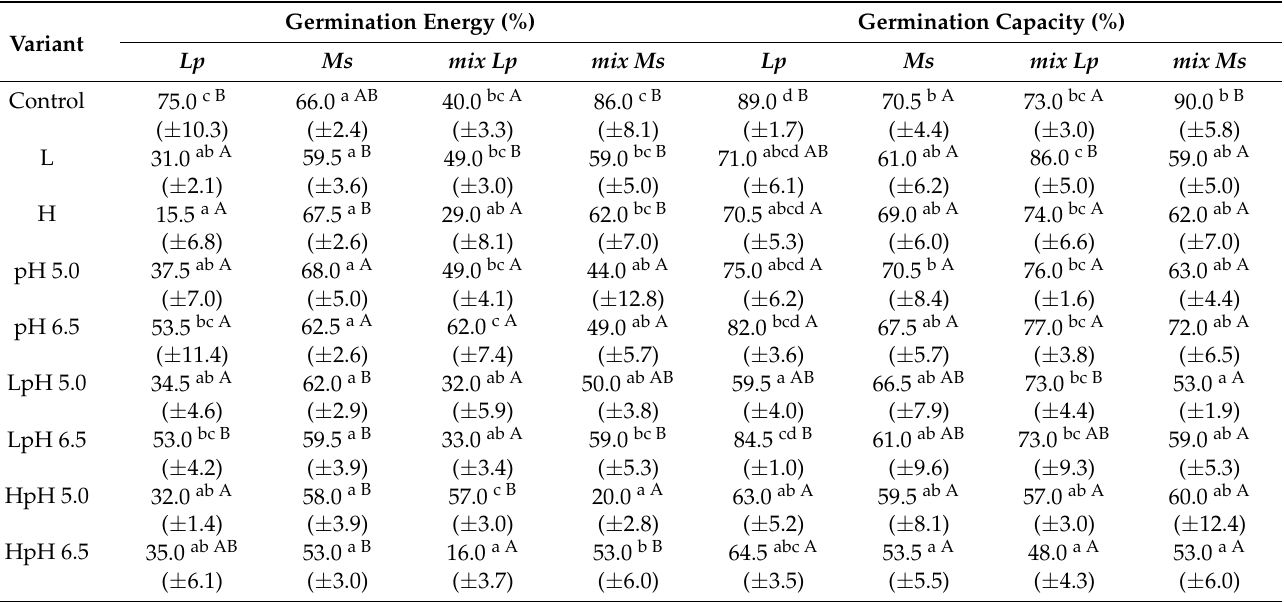
Table 6. Effects of different variants of Medicago sativa root extracts and pH of the solution on germi- nation energy and germination capacity of Lolium perenne ( Lp ) and Medicago sativa ( Ms )